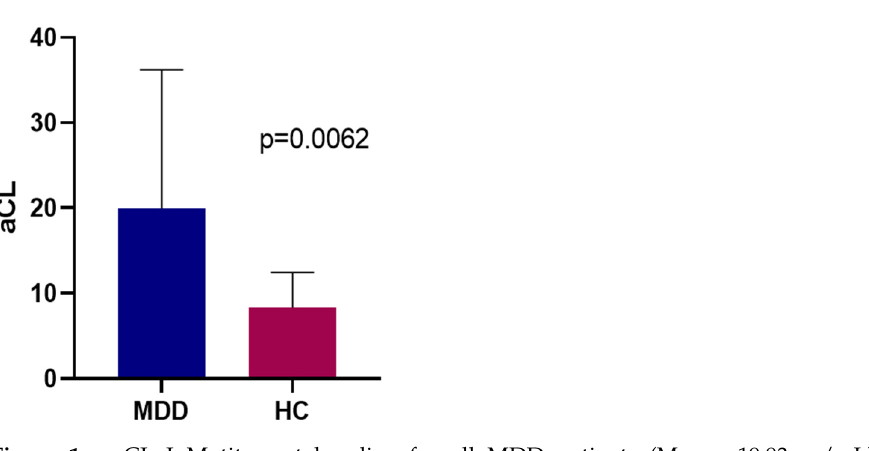
Figure 1. aCL IgM titers at baseline for all MDD patients (Mean = 19.93 µ g/mL) and HC (Mean = 8.322 µ g/mL).